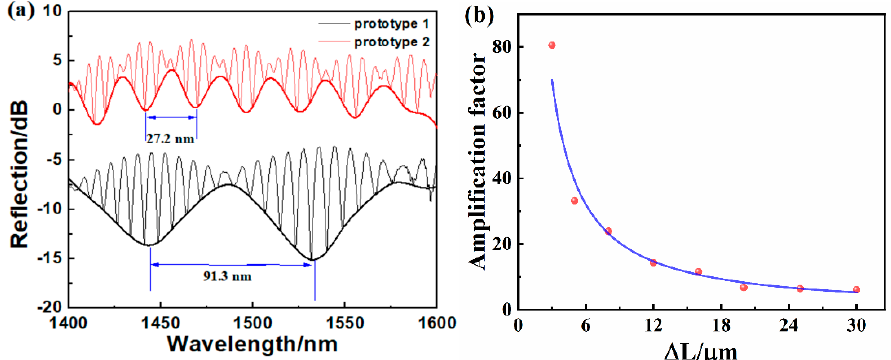
Figure 5. ( a ) Reflection spectrum of paralleled F–P cavities with different cavity length differences. ( b ) Simulated amplification factor of different cavity length differences.